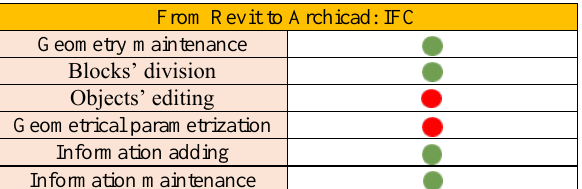
Table 9. Summarizing the result of the IFC